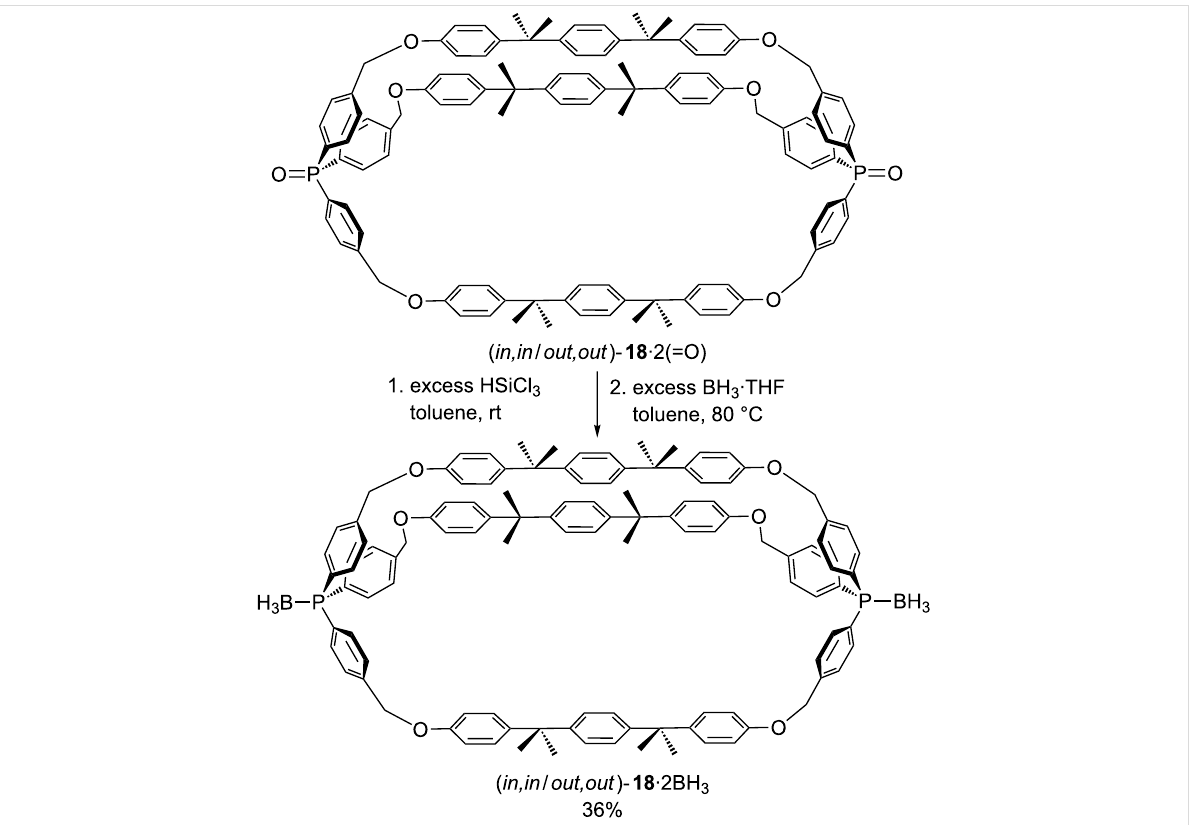
Scheme 9: Previously synthesized dibridgehead diphosphine